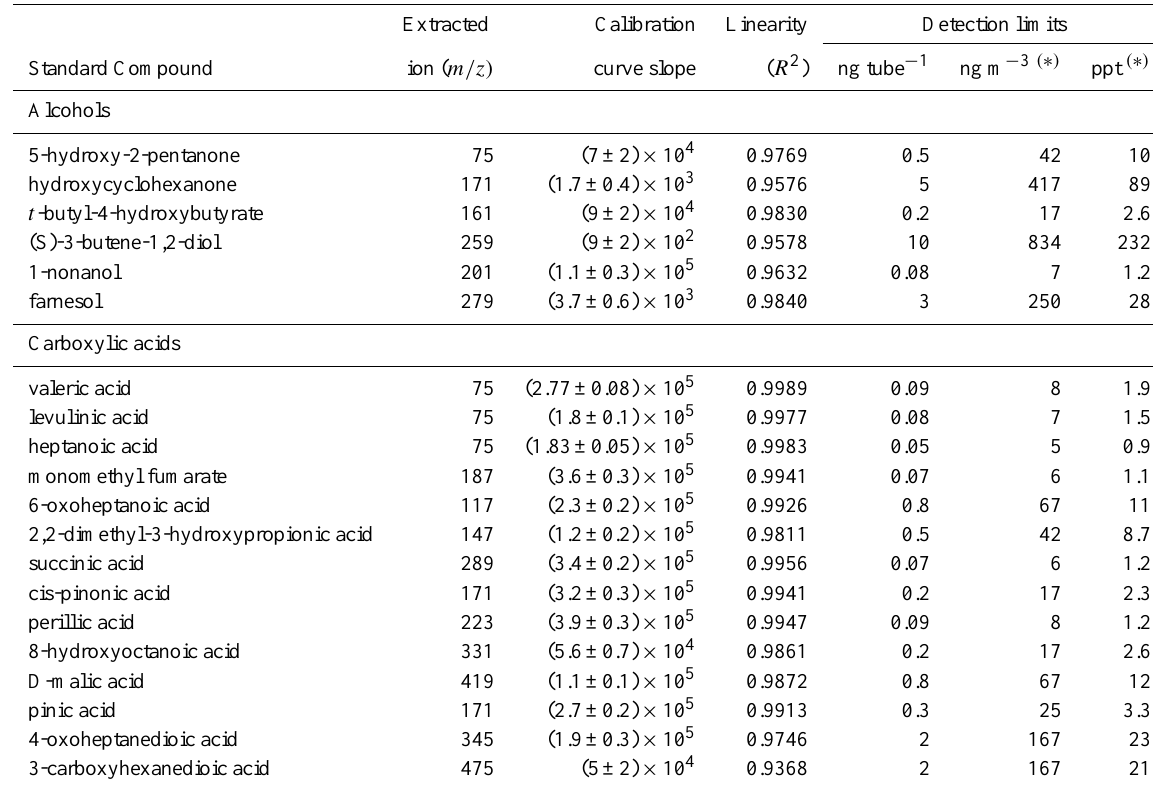
Table 3. Calibration curves slopes, linearities and detection limits for gaseous carbonyl compounds trapped on PFBHA-coated Tenax TA